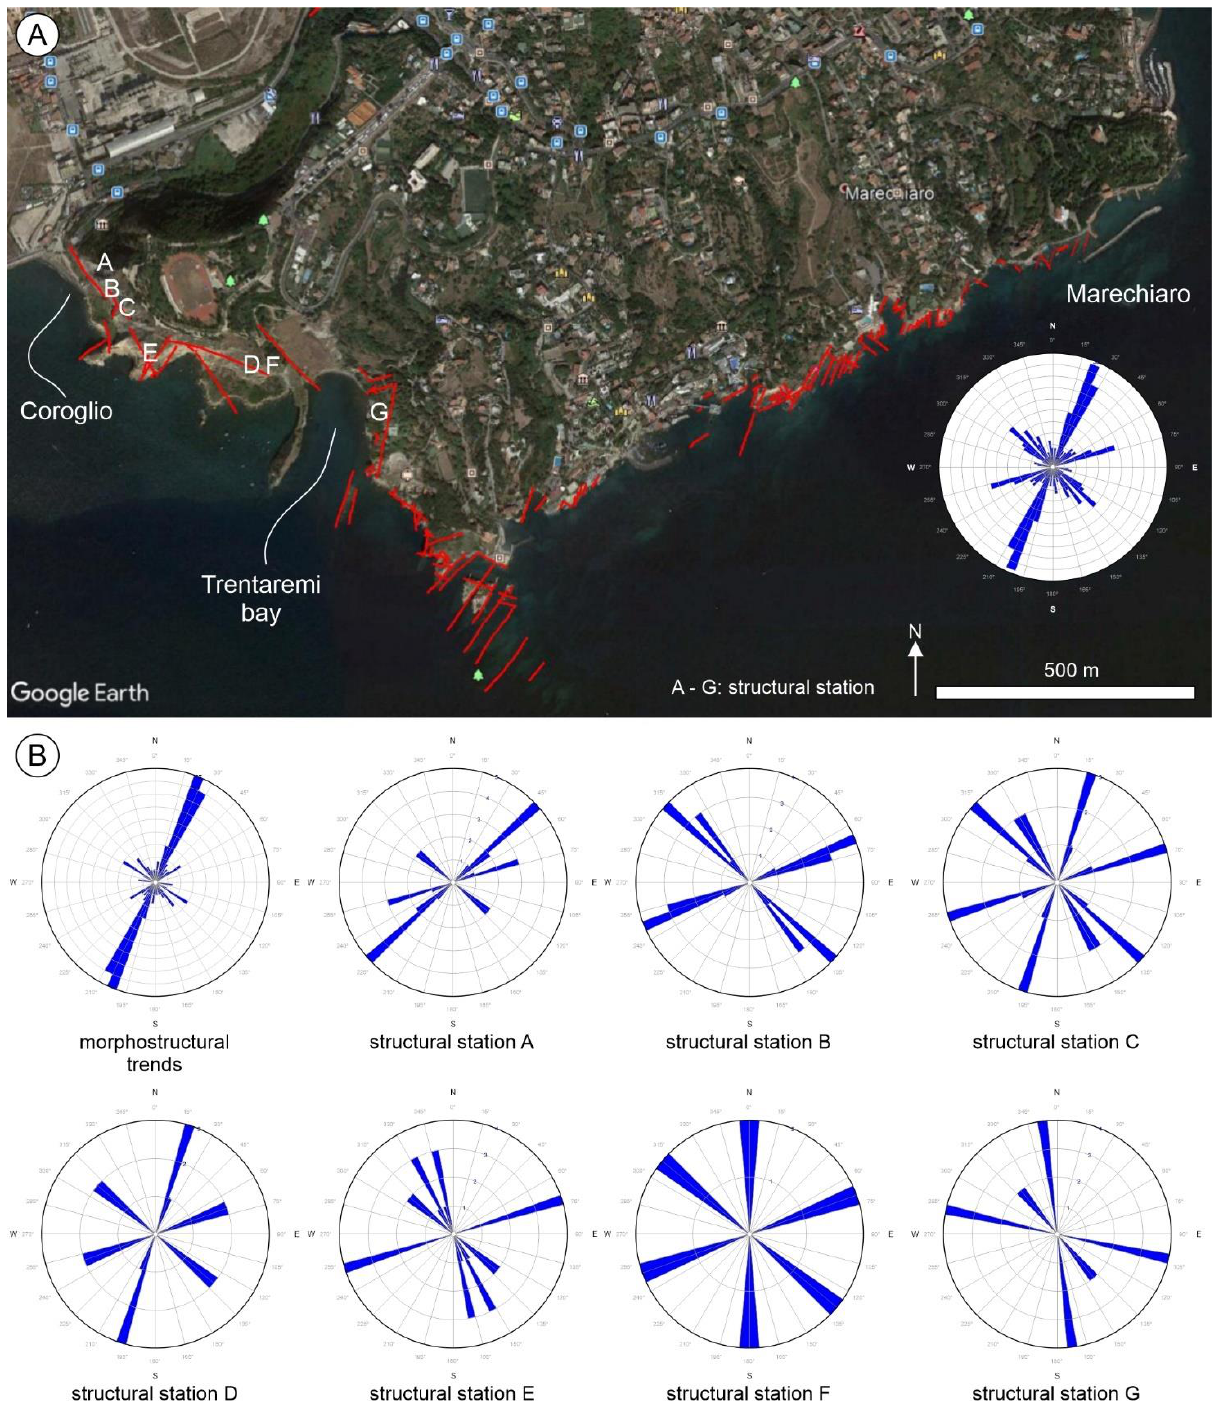
Figure 11. ( A ) Morphostructural lineaments (red lines) along the Coroglio-Trentaremi sea cliff plotted on Google Earth orthophoto. Labels A to G indicate the location of the structural stations. The rose diagram to the right of panel A shows the direction of all the morphostructural lineaments, the faults and fractures shown in the rose diagrams of panel B. ( B ) Rose diagrams showing the direction of the morphostructural lineaments and the direction of the faults and fractures measured in the single structural stations along the Coroglio-Trentaremi sea cliff. Roses represent the absolute number of data.